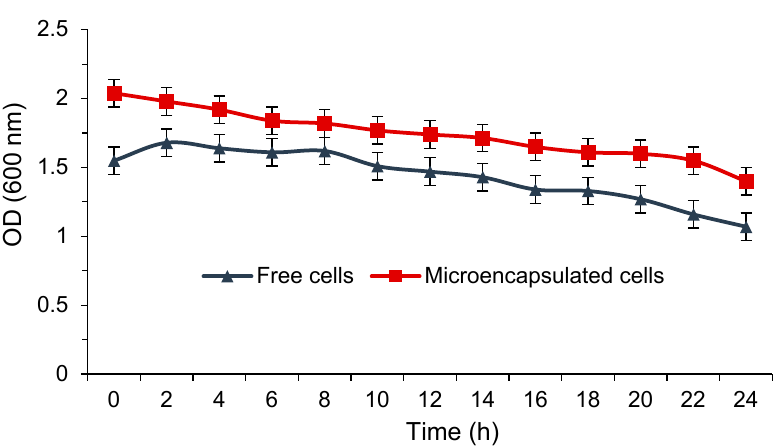
Figure 3. Cell density of free and microencapsulated L. rhamnosus .